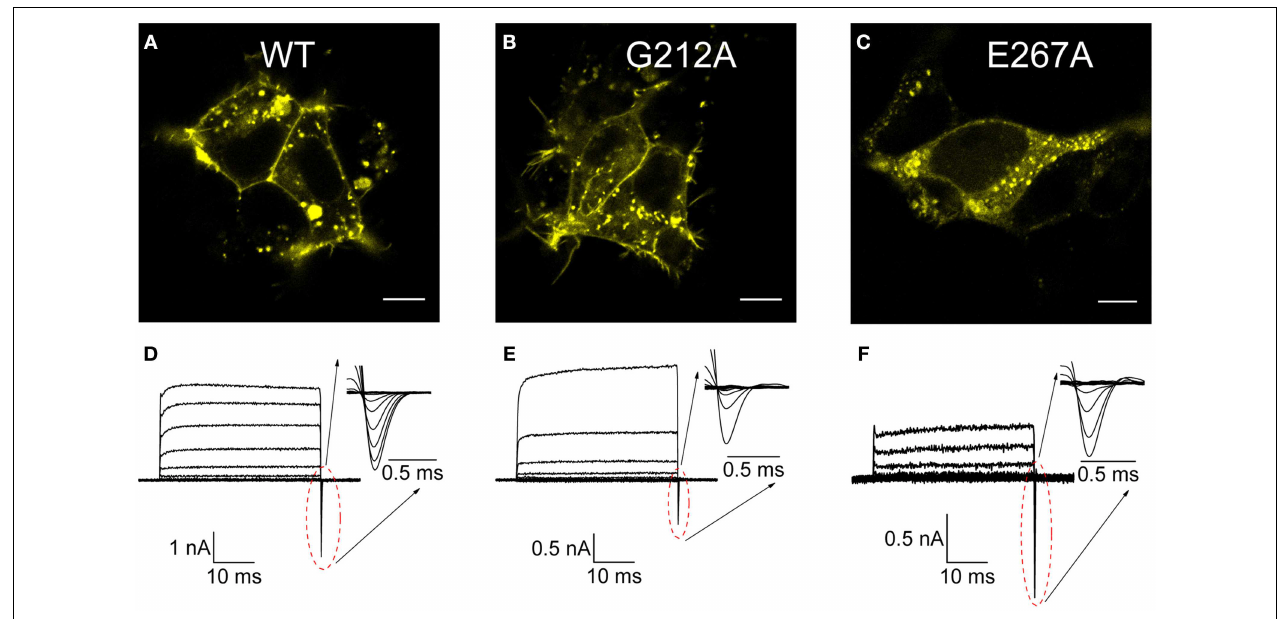
FIGURE 3 | Cellular localization and transport of WT and disease-associated ClC-5 mutants. (A–C) Confocal florescent images of cells transfected with either WT or the mutants G212A and E267A ClC-5 with fused mCherry at the C-terminus. Visible as bright fluorescent spots is the strong vesicular localization but a significant percentage of the ClC-5 proteins